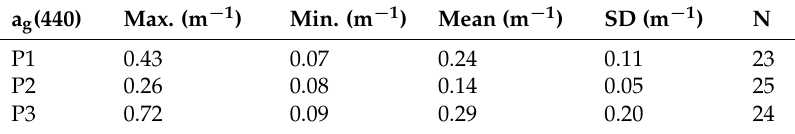
Figure 4. Spectral curve of CDOM absorption ( a ); and the CDOM absorption coefficient at 440 nm ( b ) at Stations P1 (red lines, N = 23), P2 (green lines, N = 25) and P3 (blue lines N = 24). The results show significant differences of diurnal variation of CDOM absorption at different stations. Table 2. CDOM absorption coefficients at 440 nm in the Yellow River Estuary at different stations. “Max.”, “Min.”, and “SD” stand for maximum, minimum, and standard deviation, respectively, and “N” is the number of